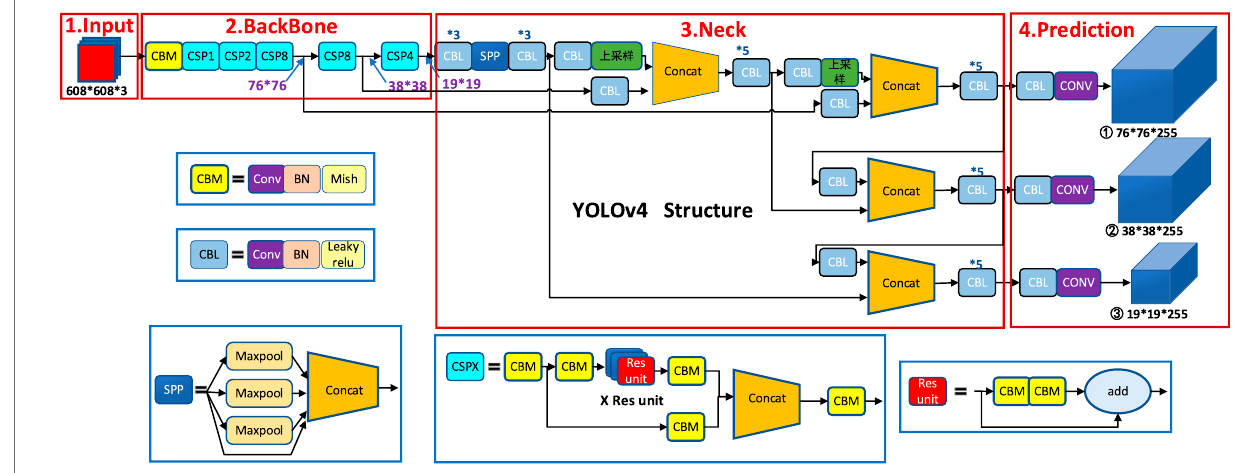
FIGURE 1 | YOLOv4 model structure.